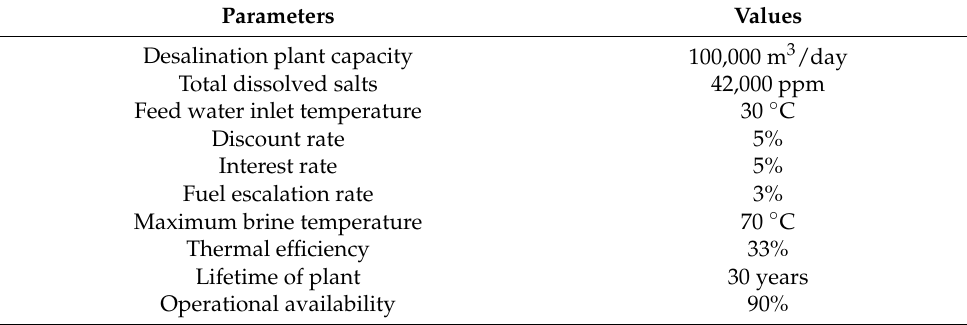
Table 5. Input parameters for